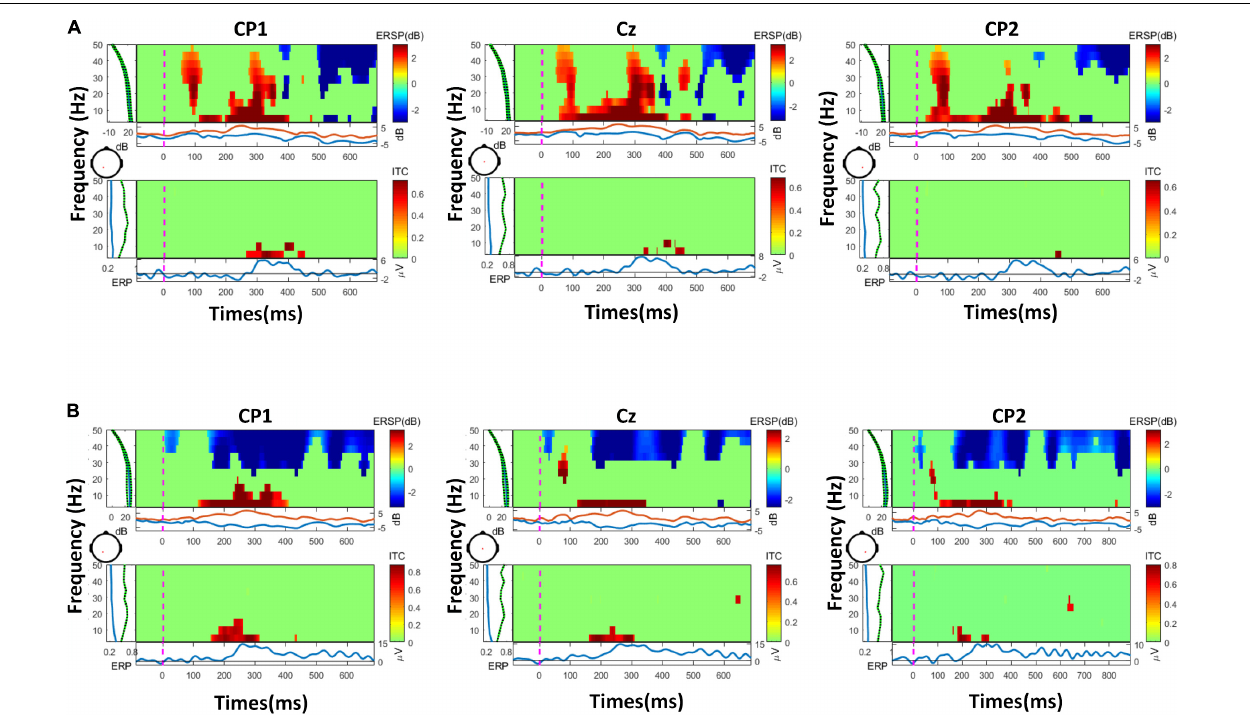
FIGURE 7 | The results of ERSP (event-related spectral perturbation) and ITC (inter-trial coherence)of two representatives, with the most frequency information in 20 Hz: (A) a representative of the vibration task, (B) a representative of the electrical